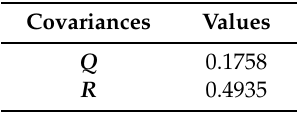
Table 5. Optimized parameters.